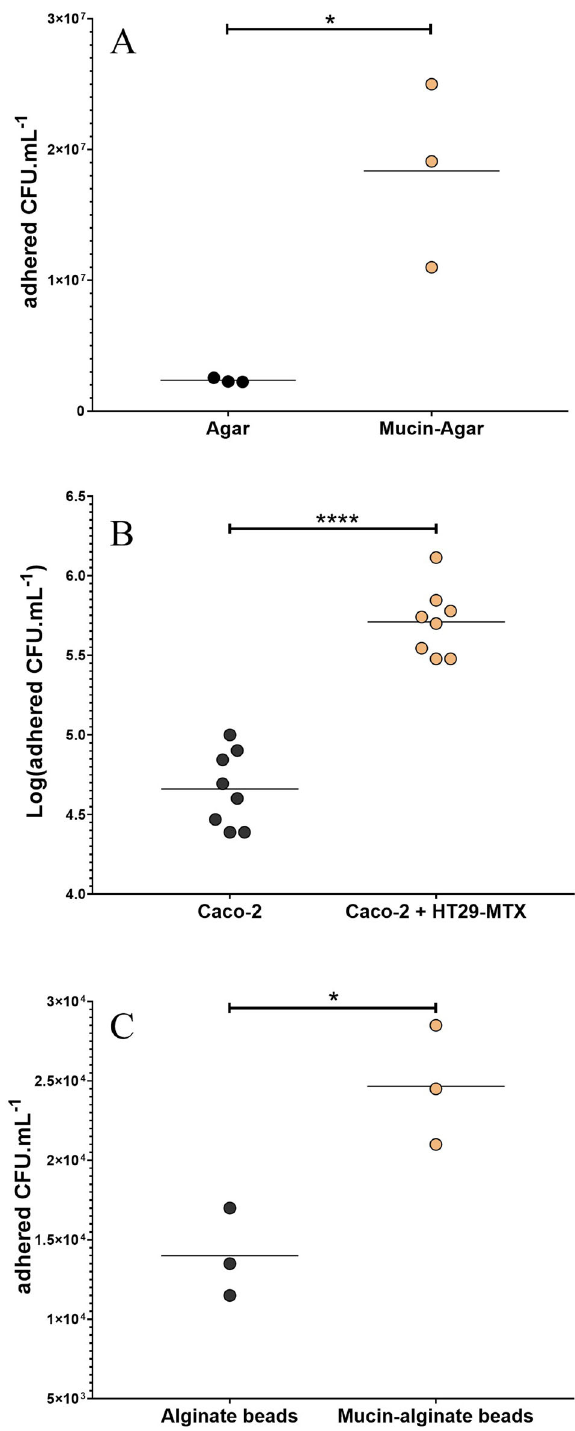
Fig. 1 ETEC adhesion to the mucus compartment. Adhesion of the ETEC strain H10407 to the mucus compartment was analyzed by three different in vitro assays. A ETEC bacteria (initial concentration: 10 7 CFU.ml − 1 ) adhered in plate assays to type II mucin-agar layer (orange dots) or agar without mucin used as a negative control (black dots) after one hour exposure. B ETEC adhesion to Caco-2/ HT29-MTX co-culture model (orange dots) or Caco-2 cells only (black dots) after infection at MOI 100 for 3 h. C ETEC bacteria (initial concentration: 10 7 CFU.ml − 1 ) adhered to type III mucin-alginate beads (orange dots) or alginate without mucin used as a negative control (black dots), after one hour and half static gastro-ileal digestion procedure. Figures represent the results of three independent experiments (in B , all technical replicates are repre- sented). Means are indicated by black bars. p -values are provided by unpaired t test with Welch ’ s correction (* p < 0.05; **** p <